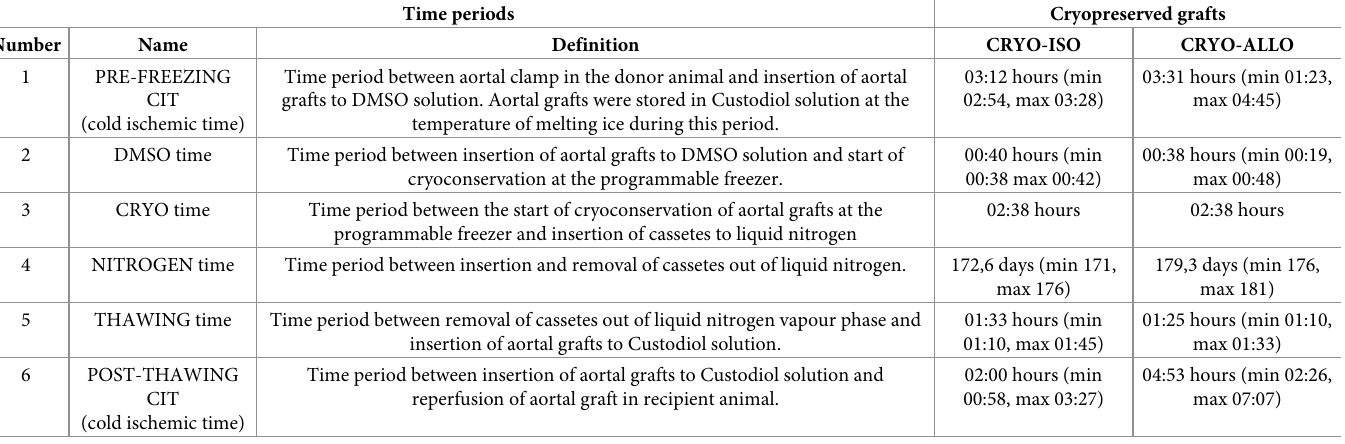
Table 1. Time-periods of the cryoconservation/slow thawing procedure.